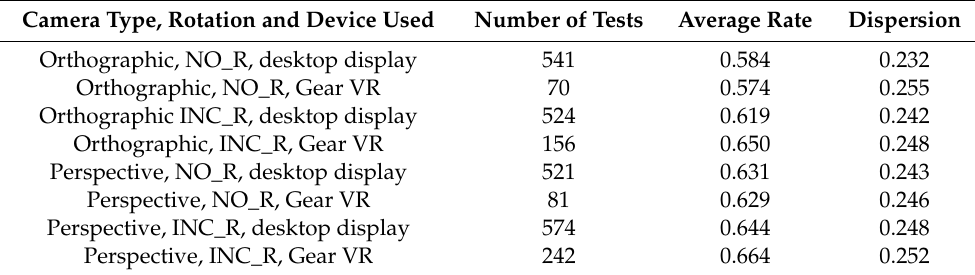
Table A16. Numerical results of the users regarding the camera type, rotation and device used. Camera Type, Rotation and Device Used